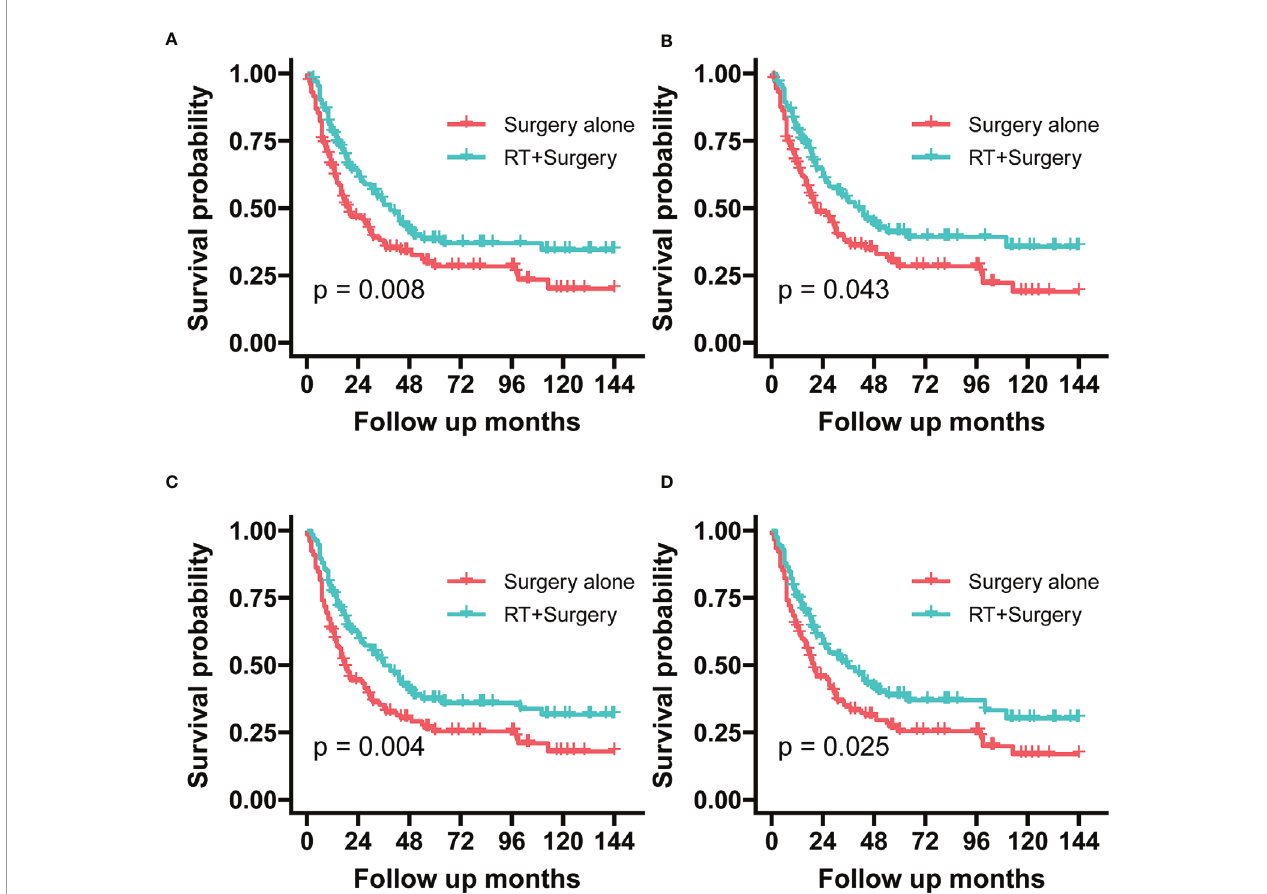
FIGURE 4 | The graphs show Kaplan – Meier survival curves of sarcoma speci fi c survival and overall survival in (A, C) unadjusted and (B, D) IPTW-adjusted cohorts of patients with STSE-RLNM.